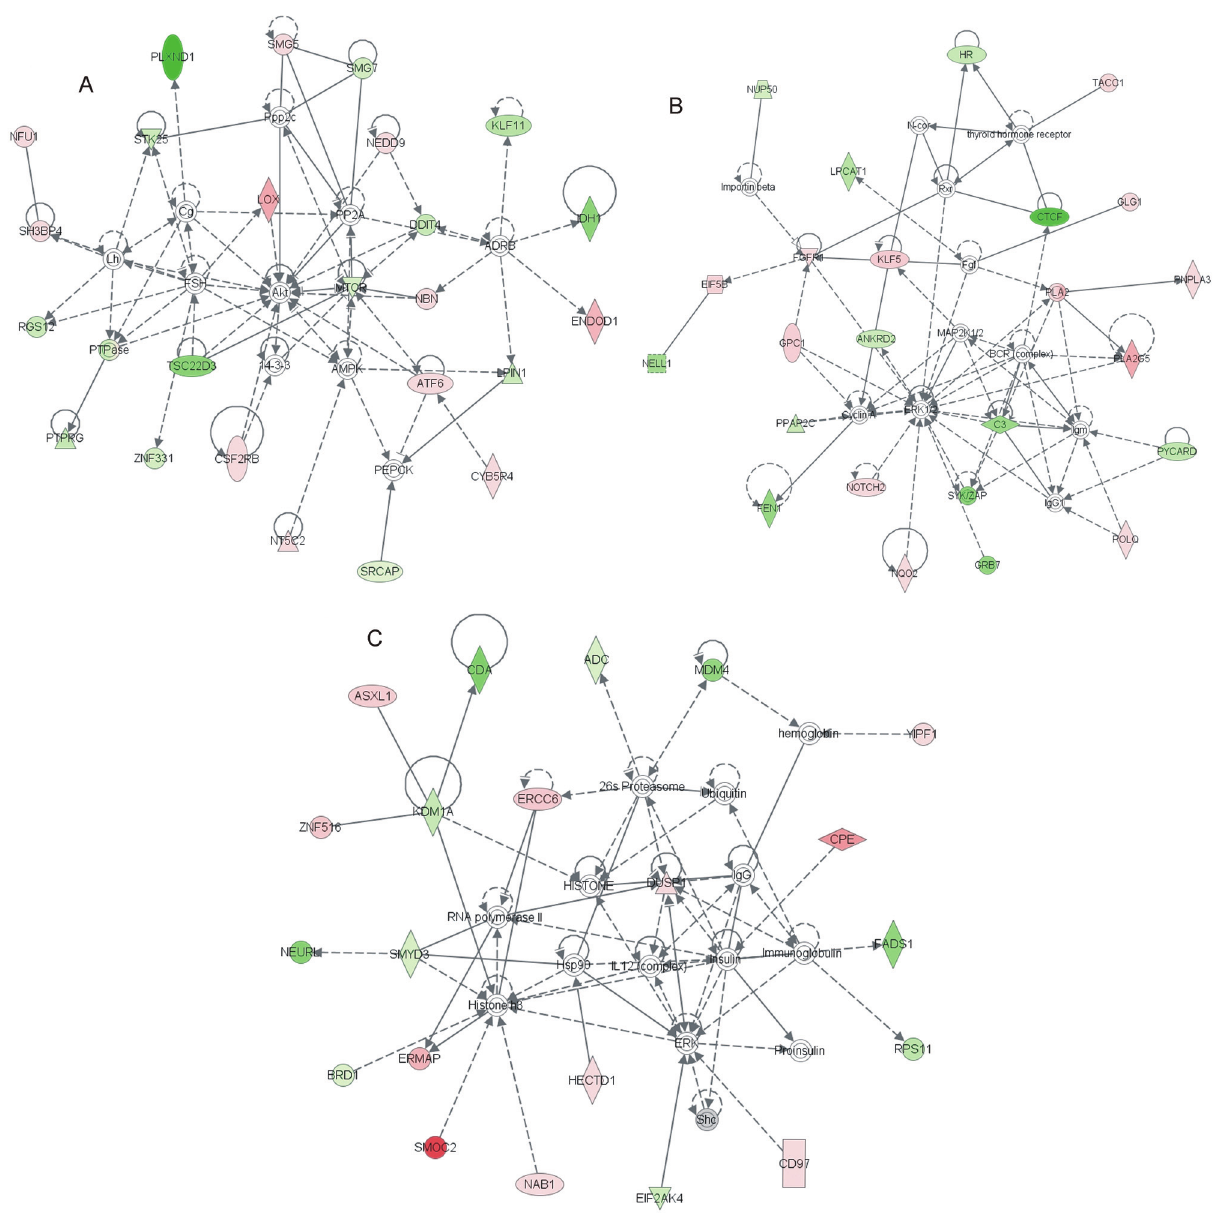
Figure 2 - Top networks observed in Ingenuity Pathway Analysis (IPA). (A) Network based on skeletal and muscular system development and function, cellular assembly and organization, cellular growth and proliferation. (B) Network based on connective tissue disorders, inflammatory disease, skeletal and muscular disorders. (C) Network based on cellular development, digestive system development and function, and embryonic development. The 267 genes differentially expressed among CAF, N+ and BMMC, as well as the fold change of CAF/BMMC, were used as input data for this analysis. Small circles identify proteins that act as hubs to interconnect groups of proteins to create protein clusters in pathways. Proteins in red were more expressed in bone marrow mesenchymal cells, whereas proteins in green were less expressed in bone marrow mesenchymal cells. Solid lines represent direct relation- ships. Lines connecting the proteins indicate known interrelationships obtained from the IPA